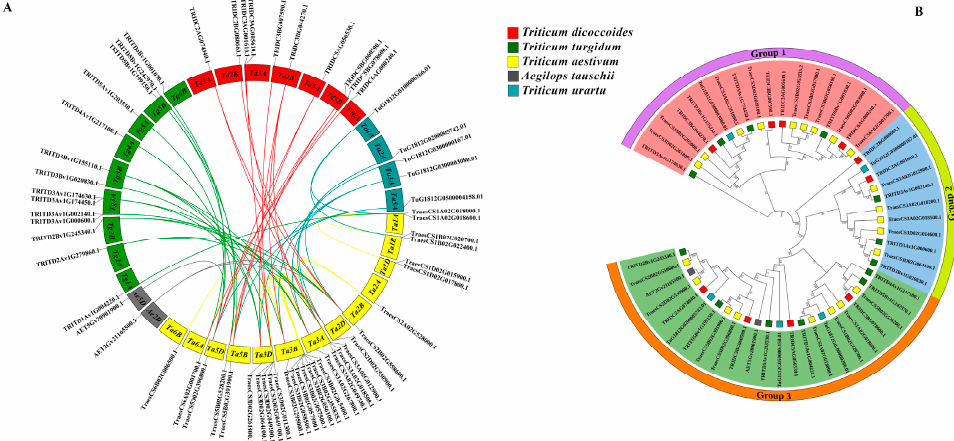
Figure 4. Syntenic and evolutionary analysis of TaPSTOL1 orthologs with ancestral species. ( A ) Synteny analysis. ( B ) Phylogenetic tree of 22 Triticum aestivum L. PSTOL1 orthologs with Aegilops tauschii , Triticum urartu , Triticum dicoccoides , and Triticum turgidum . Red-colored rectangles represent T. dicoccoides , green for T. turgidum , gray for A. tauschii , blue for T. urartu , and yellow for T. aestivum L.